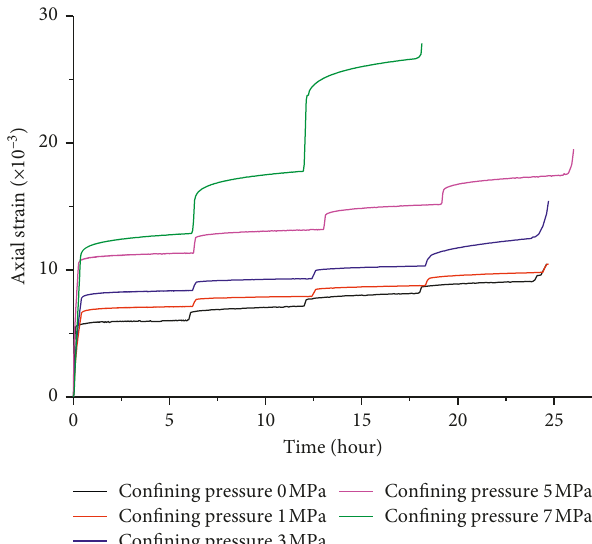
Figure 11: Strain-time curves obtained from triaxial multistage creep experiments for the shale-like material under different confining pressures (T � 60 ° Table 5: Creep strain rate of each stage at different confining pressures.